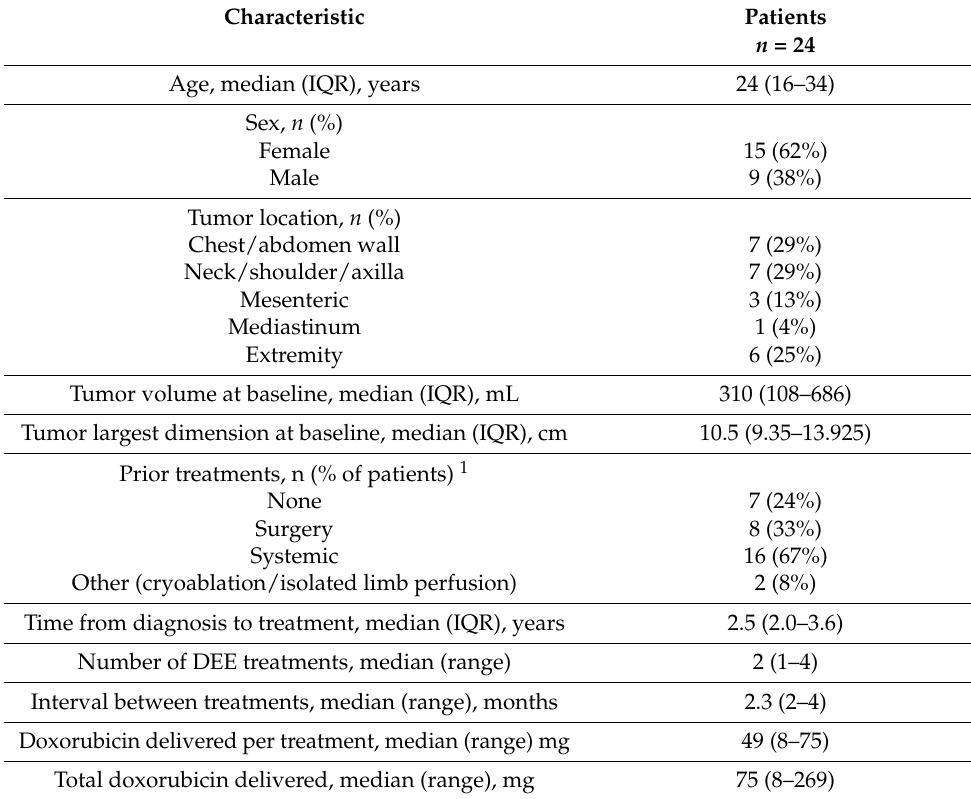
Table 1. Patient/tumor characteristics and treatment